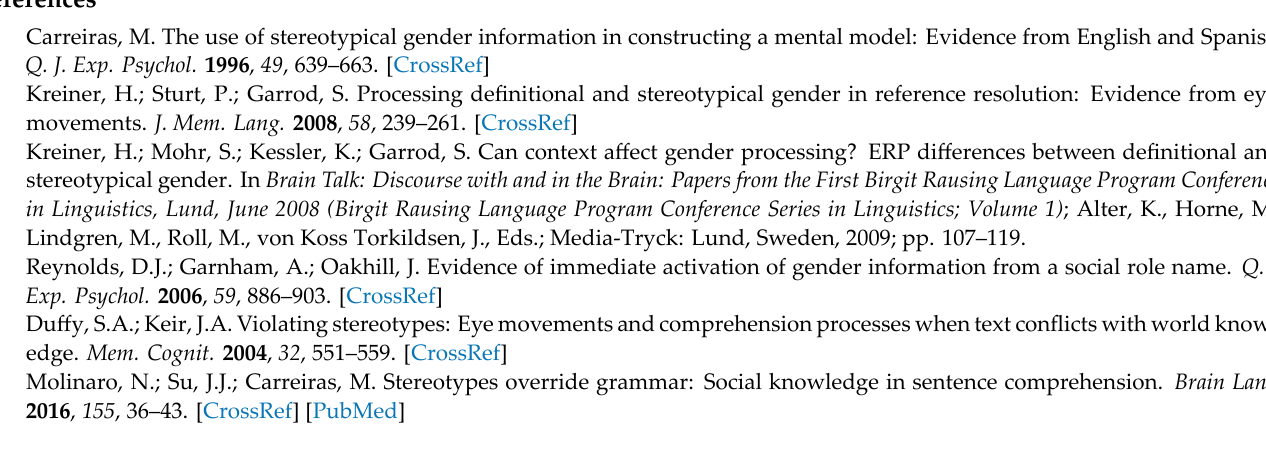
Table S2: Summary of linear mixed effect model for the N400 (300–600 ms) time window. Table S3: Analysisofdeviance(TypeIIWaldchi‑squaretests)fortheN400(300–600ms)timewindow. Table